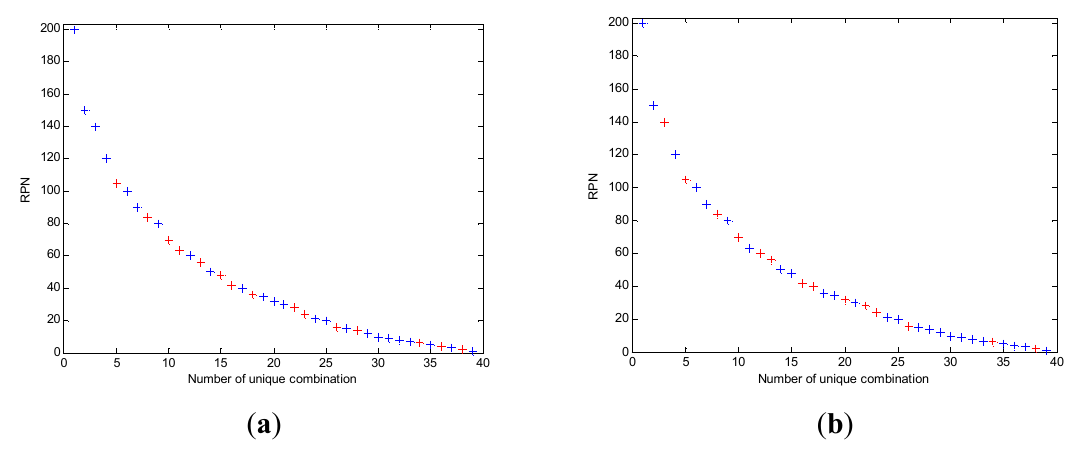
Figure 7. The RPN values ( + ), out of the 39 different RPN values ( + , + ), obtained for the ( a ) onshore and ( b ) offshore wind turbine